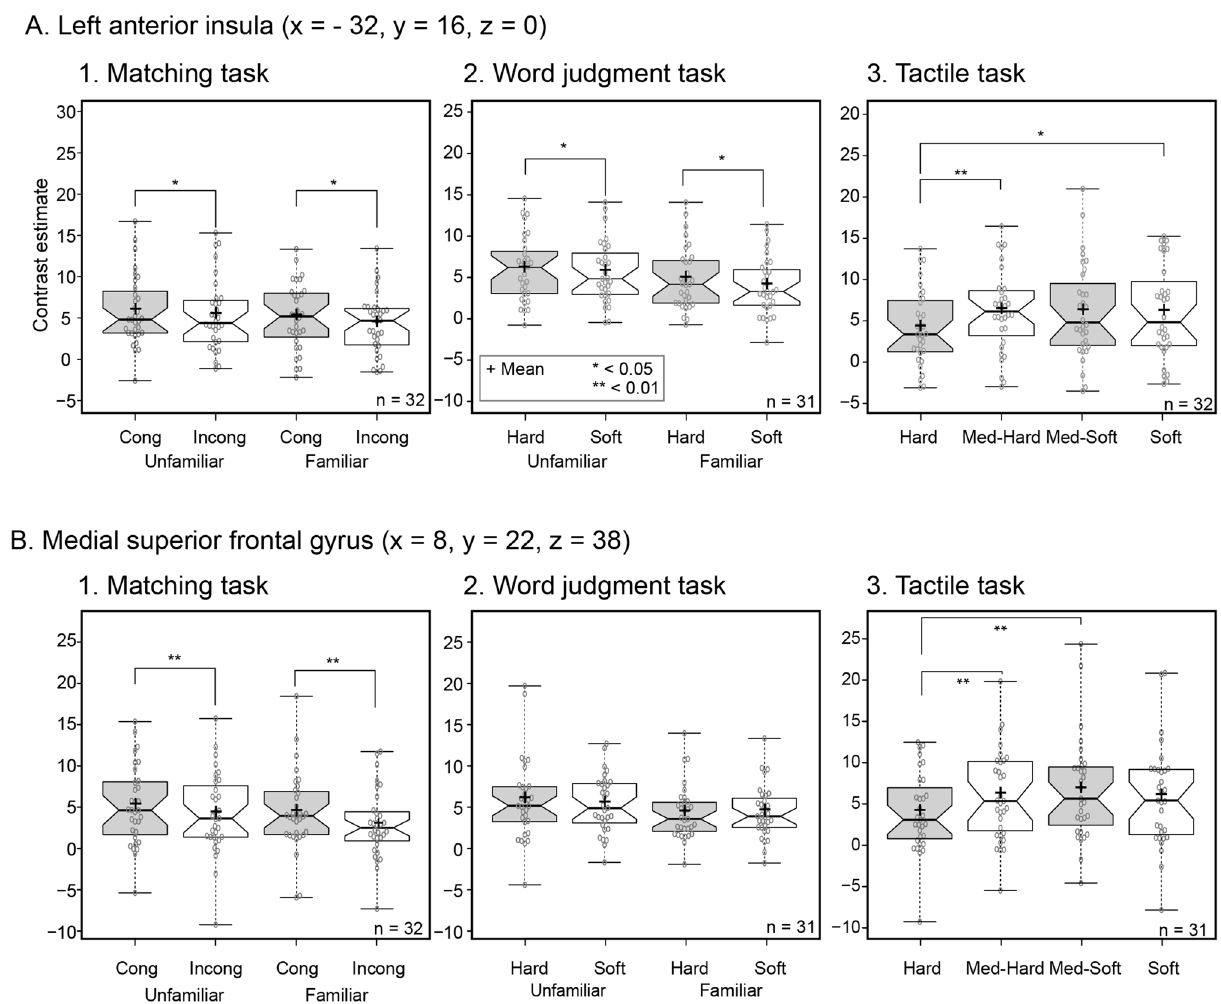
Figure 5. Volume-of-interest analysis. Activity (parameter or contrast estimates) extracted from the volumes of interest (VOIs) that were defined with the independent data set (the main experiment in Kitada et al. 28 ). Data are presented as boxplots, where the box indicates the interquartile range [IQR, from 25th percentile (Q1) to 75th percentile (Q3)]. The thick line and black cross in the box indicate the median and mean, respectively. Whiskers indicate the maximum and minimum value. Circles and notches of the boxes indicate data points and 95% confidence levels, respectively. Asterisks and symbols indicate the result of ANOVA for the matching and word judgment tasks, and the result of post-hoc pairwise comparisons (with Bonferroni correction) for the tactile task. Note that one subject’s data was excluded from the analysis of the word judgment task due to technical issues. The figure was made with BoxPlotR (http:// shiny. chemg rid. org/ boxpl greater activity in the all ROIs [F(1, 30) = 23.7, p < 0.001 for the left insula; F(1, 30) = 14.5, p = 0.001 for the supe- rior frontal gyrus]. None of the regions showed significant interaction ( p values > 0.1). Tactile task. Two-way repeated-measures ANOVA (4 levels of softness) on the contrast estimates (relative to the control) revealed a significant main effect in all regions [F(3, 93) = 4.7, p = 0.004 for the insula; F(3, 93) = 7.1, p < 0.001 for the superior frontal gyrus]. Pairwise comparisons with Bonferroni correction showed that the con- trast estimates for the hardest stimulus were lower than those for the second-hardest (Med-Hard) stimulus in both regions ( p values < 0.01), lower than those for the softest stimulus in the left insula ( p = 0.033), and lower than those for the second-softest stimulus (Med-Soft) in the superior frontal gyrus ( p = 0.007). These results confirm that the insula and superior frontal gyrus are affected by the magnitude of tactually perceived softness. Multi‑voxel pattern analysis. The univariate anlaysis showed the matching effect in the insula nad medial supe- rior frontal gyrus, whereas no such effect was found in the pSTS. To further examine whether the pSTS contains information about sound symbolic information and its matching effect with tactile information, we conducted a multi-voxel pattern analysis (MVPA) (Fig. 6). Based on our previous studies 16,18,28 the insula/PO, medial part of superior frontal gyrus, and pSTS were chosen as ROIs. All ROIs in all tasks showed significantly greater accuracy than chance level ( p values < 0.05 Bonferroni corrected).